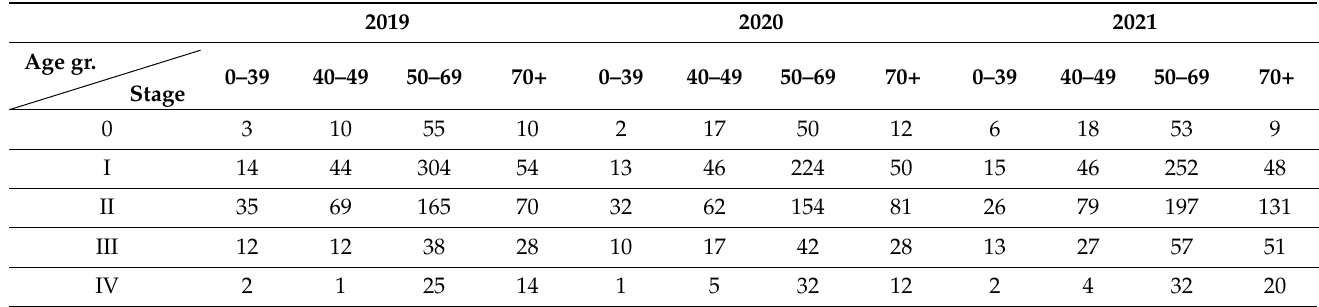
Table 4. Number of cases grouped by age and stage of BC in 2019–2021.